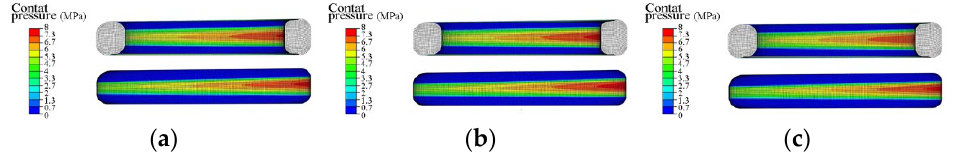
Figure 14. Contact pressure distribution of O-ring under different working distances. ( a ) 0 km; ( b ) 7.2 km; ( c ) 28.8 km.